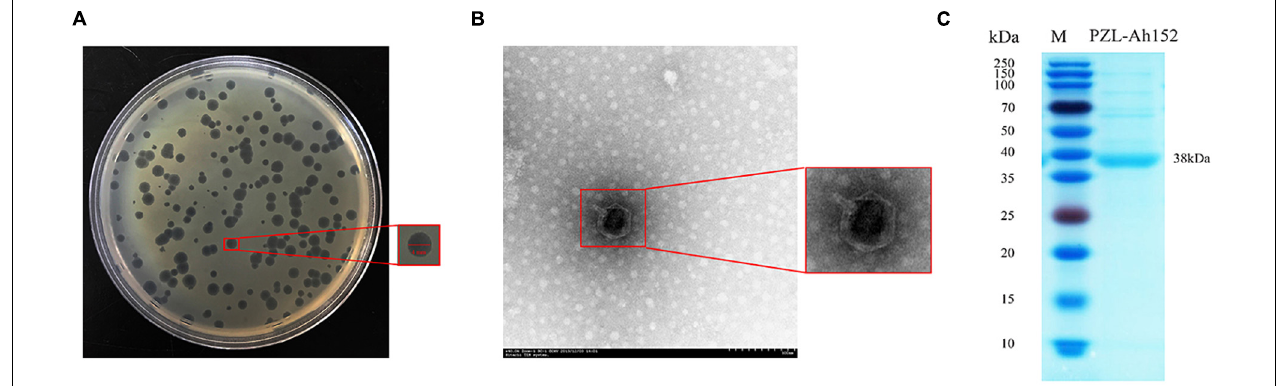
FIGURE 1 | Phage morphology and structural protein detection. (A) Bacteriophage PZL-Ah152 spotted onto A. hydrophila -152 culture on LB agar. Each single plaque was ≈ 4 mm in diameter. (B) TEM image showing the icosahedral head and sheathed tail tube with the tail fiber of PZL-Ah152. Bar = 100 nm.